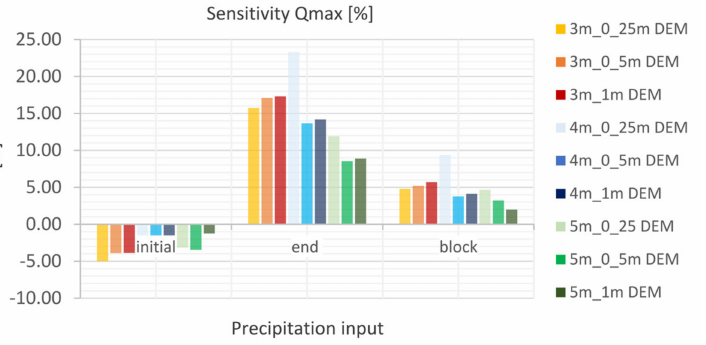
Figure 36. Comparison of the model sensitivity (S-Qmax) for the precipitation distribution and the evaluated mesh and DEM resolutions.